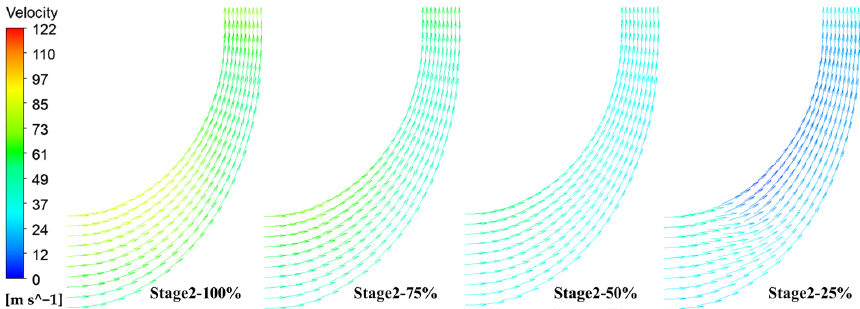
Figure 21. Impeller velocity vector diagram for the second stage compression with R-513A refrigerant under various loads.